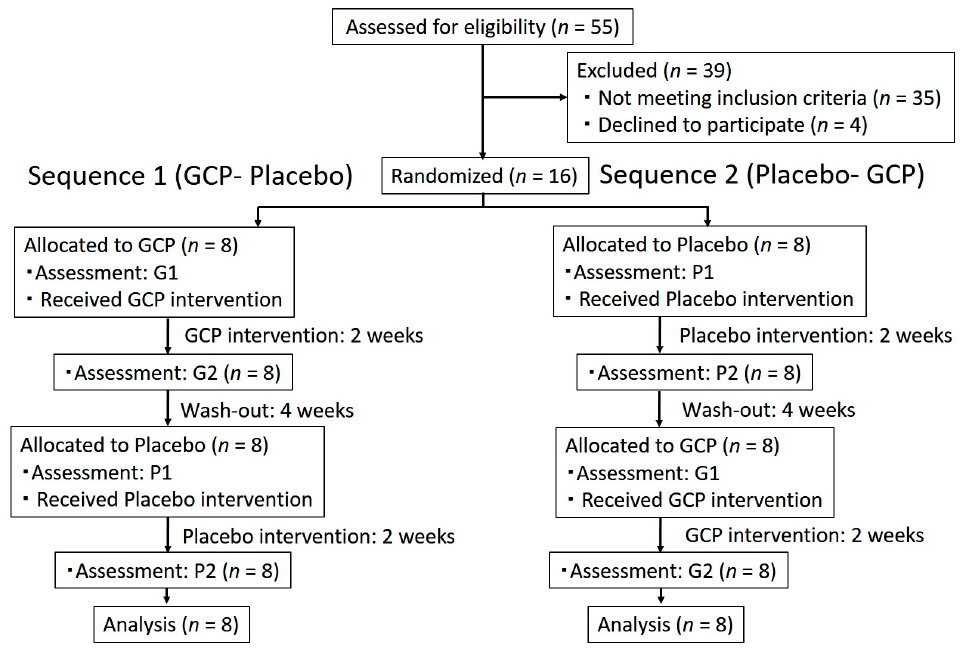
Figure 1. G1: Moisture level measured before taking GCP tablets, G2: Moisture level measured after taking GCP tablets, P1: Moisture level measured before taking Placebo tablets, P2: Moisture level measured after taking Placebo tablets. Flow chart for our randomized crossover trial. (G1 and G2) and (P1 and P2) are before and after taking the glucosylceramide extracted from pineapple (GCP) and placebo test sample, respectively.